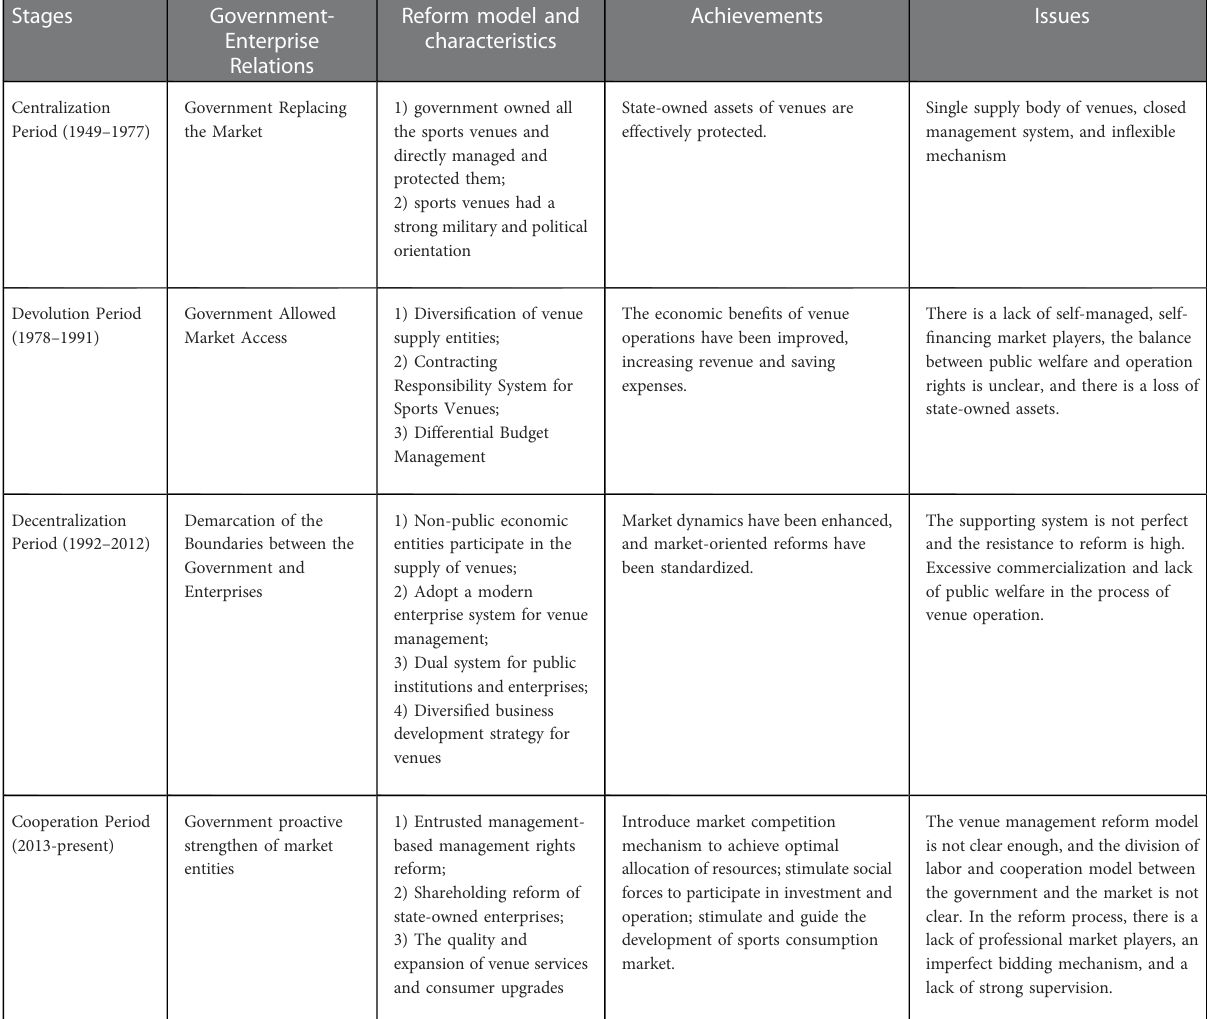
TABLE 1 Four stages of the development and reform process of sports venues in